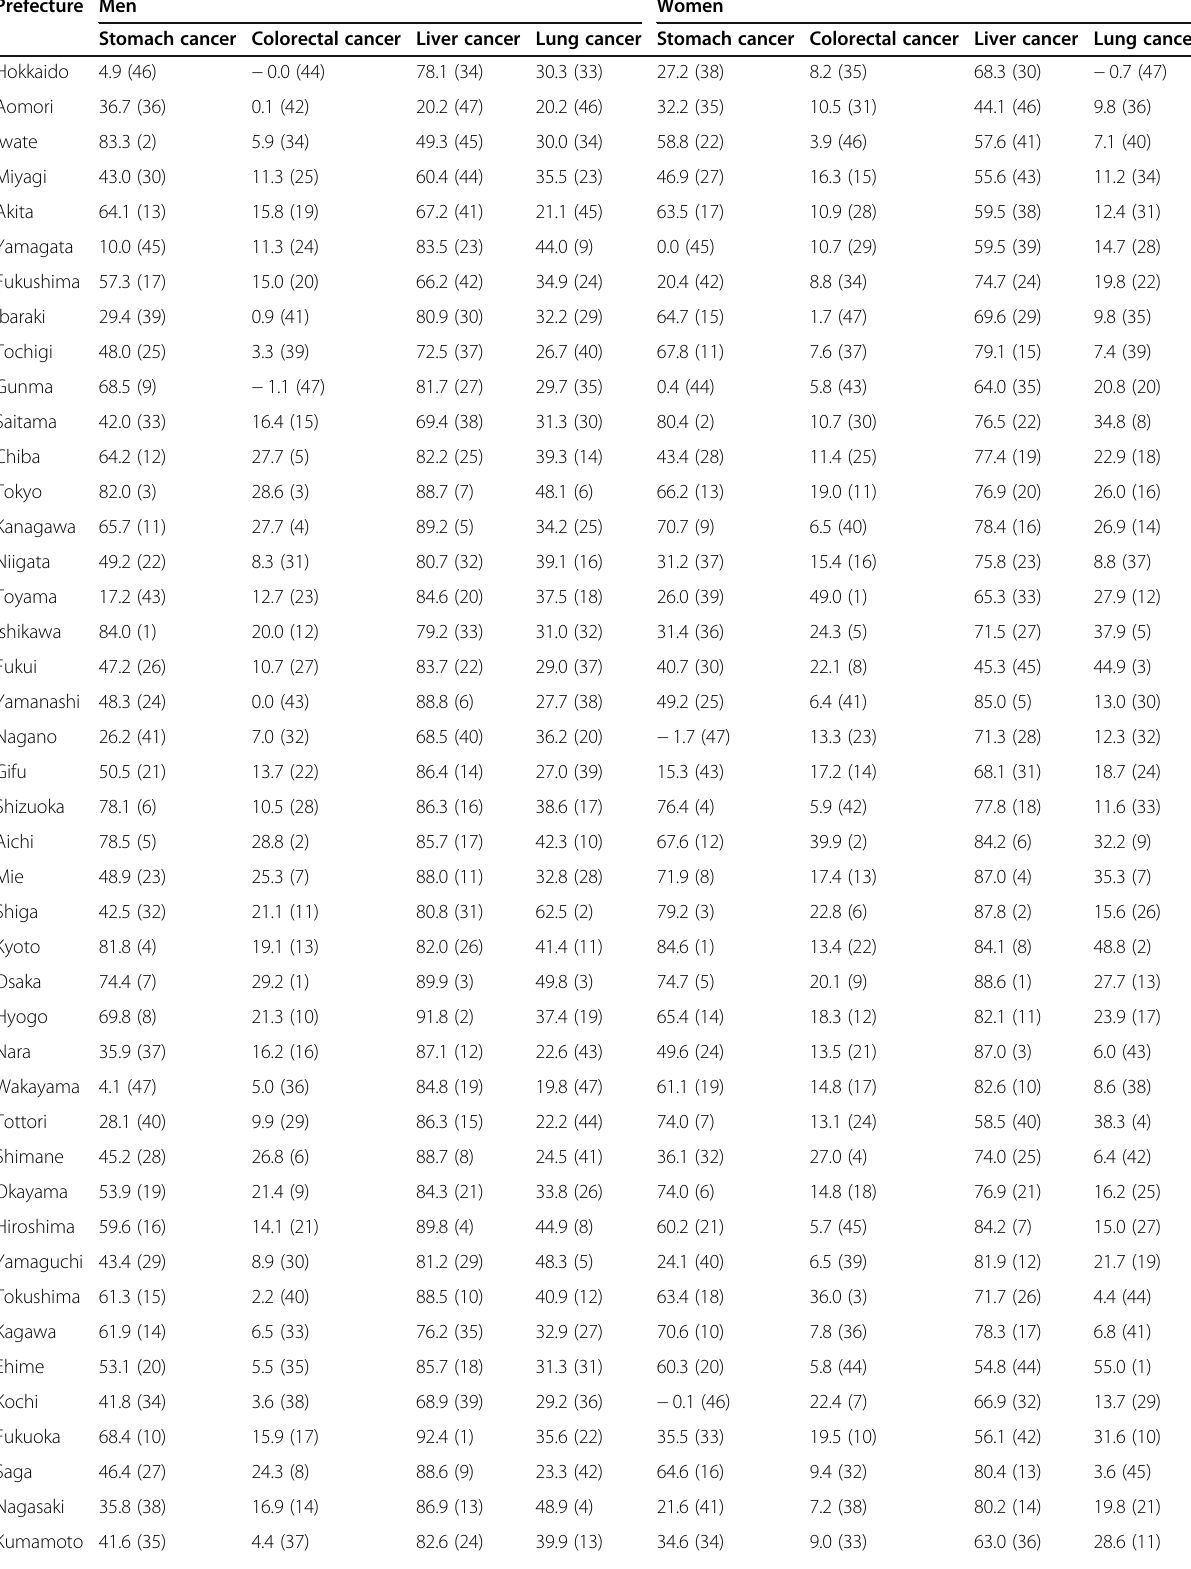
Table 3 Decreasing rates of cohort effects among prefectures and the ranks of the decreasing rates Prefecture Men